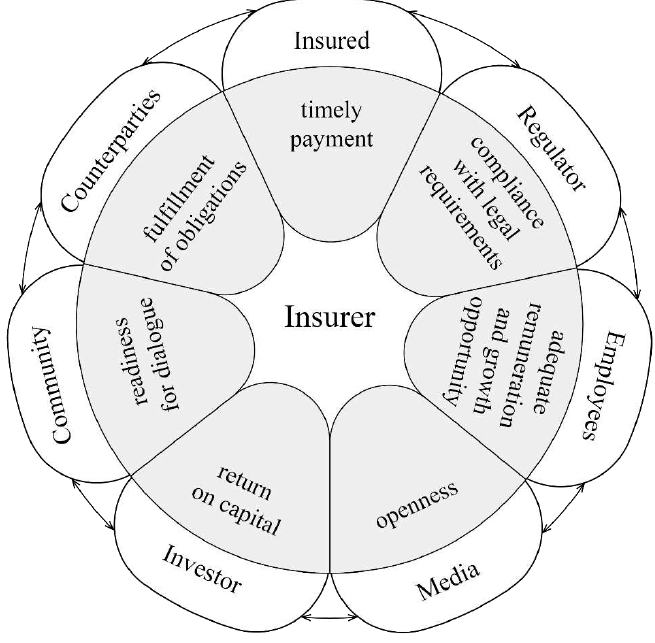
Figure 1. Kaleidoscope of reputation